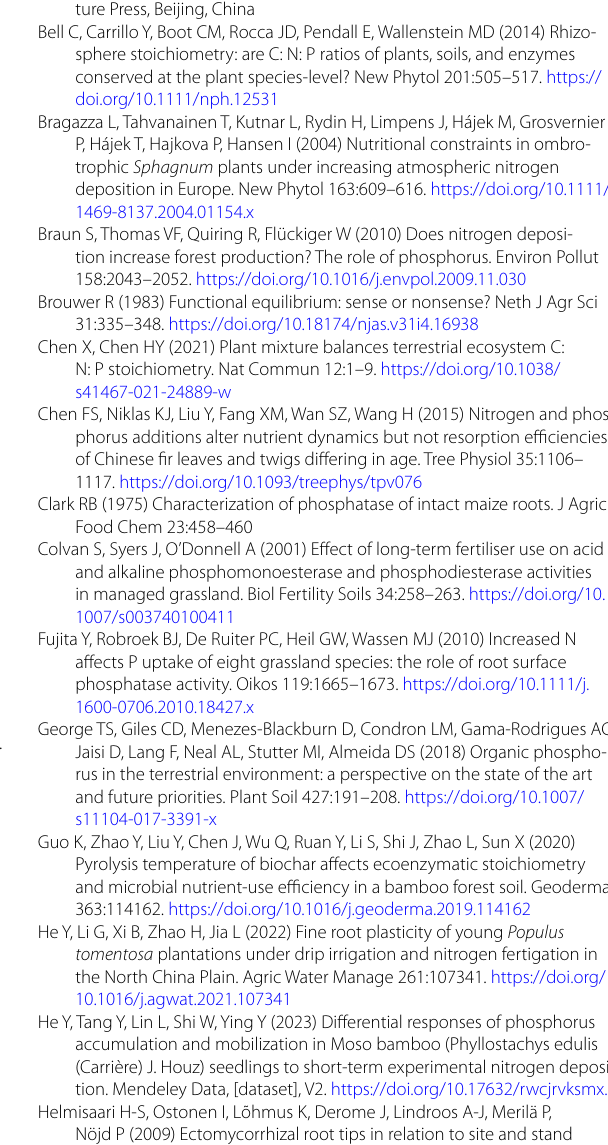
N + 0.06 cd 2.37 0.03 d ± ±